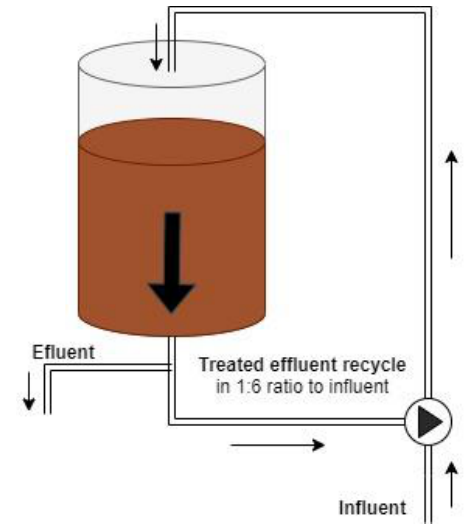
Figure 5. The reactor that provides the Dranco process.